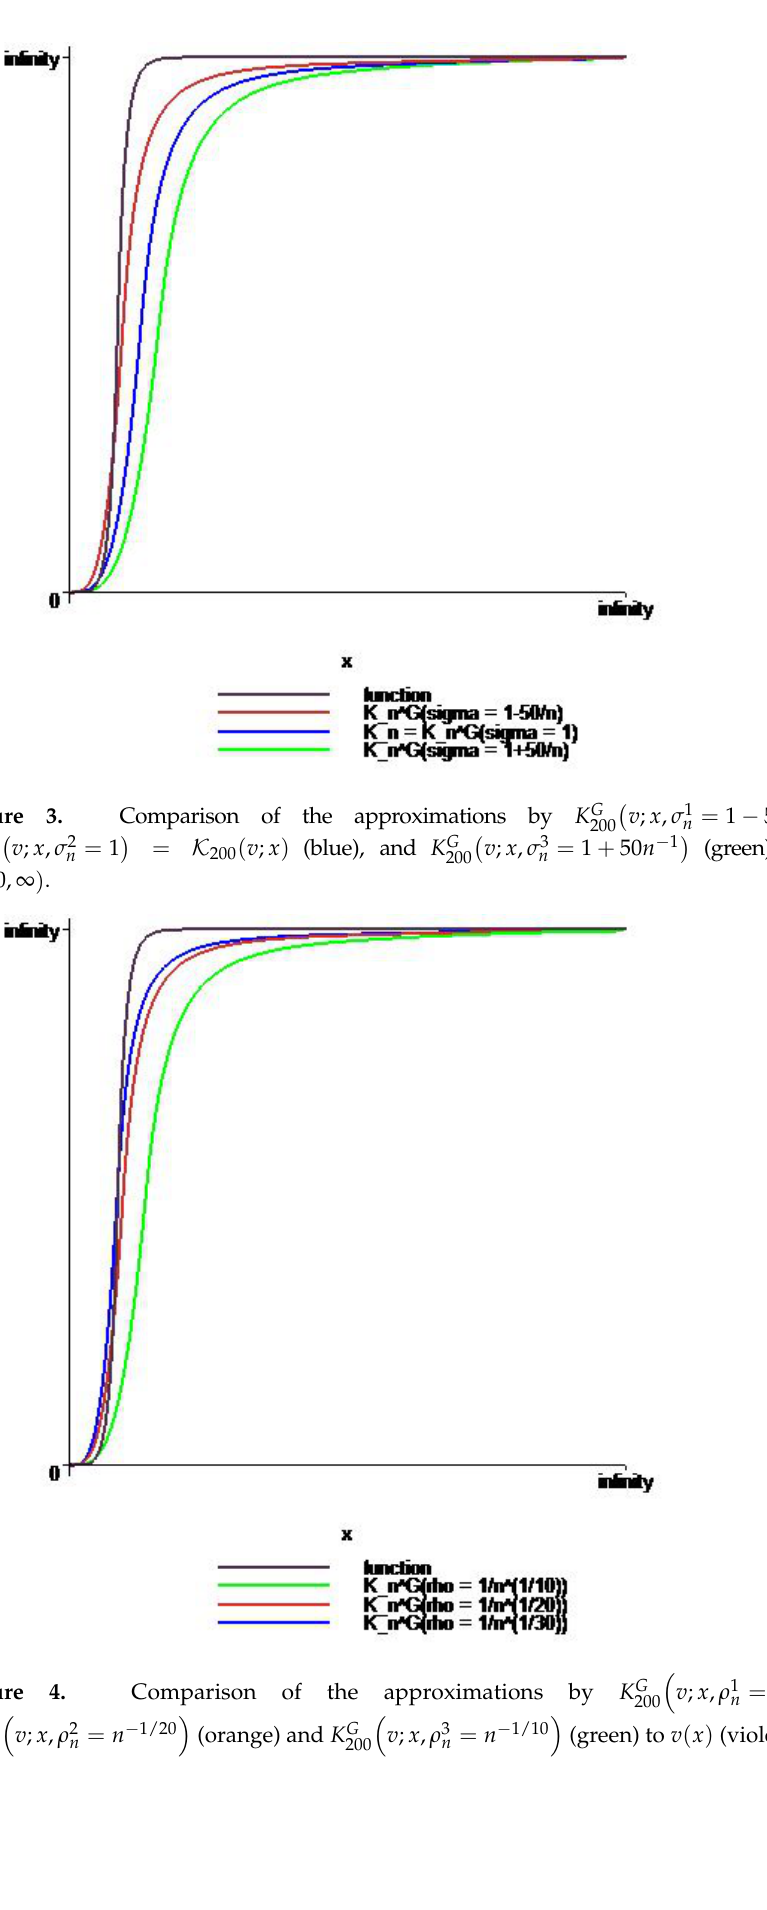
(cid:17) (orange) and K G